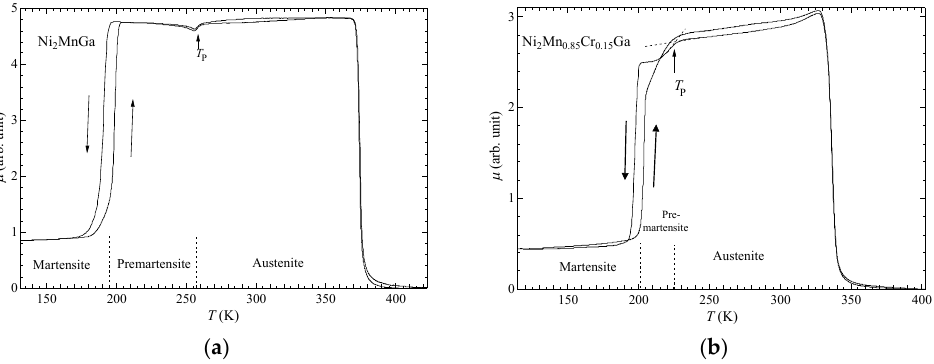
Figure 2. The permeability of the ( a ) x = 0.00 alloy; and ( b ) x = 0.15 alloy during heating and cooling in zero magnetic fields. The quantity T P is the premartensitic transition temperature.